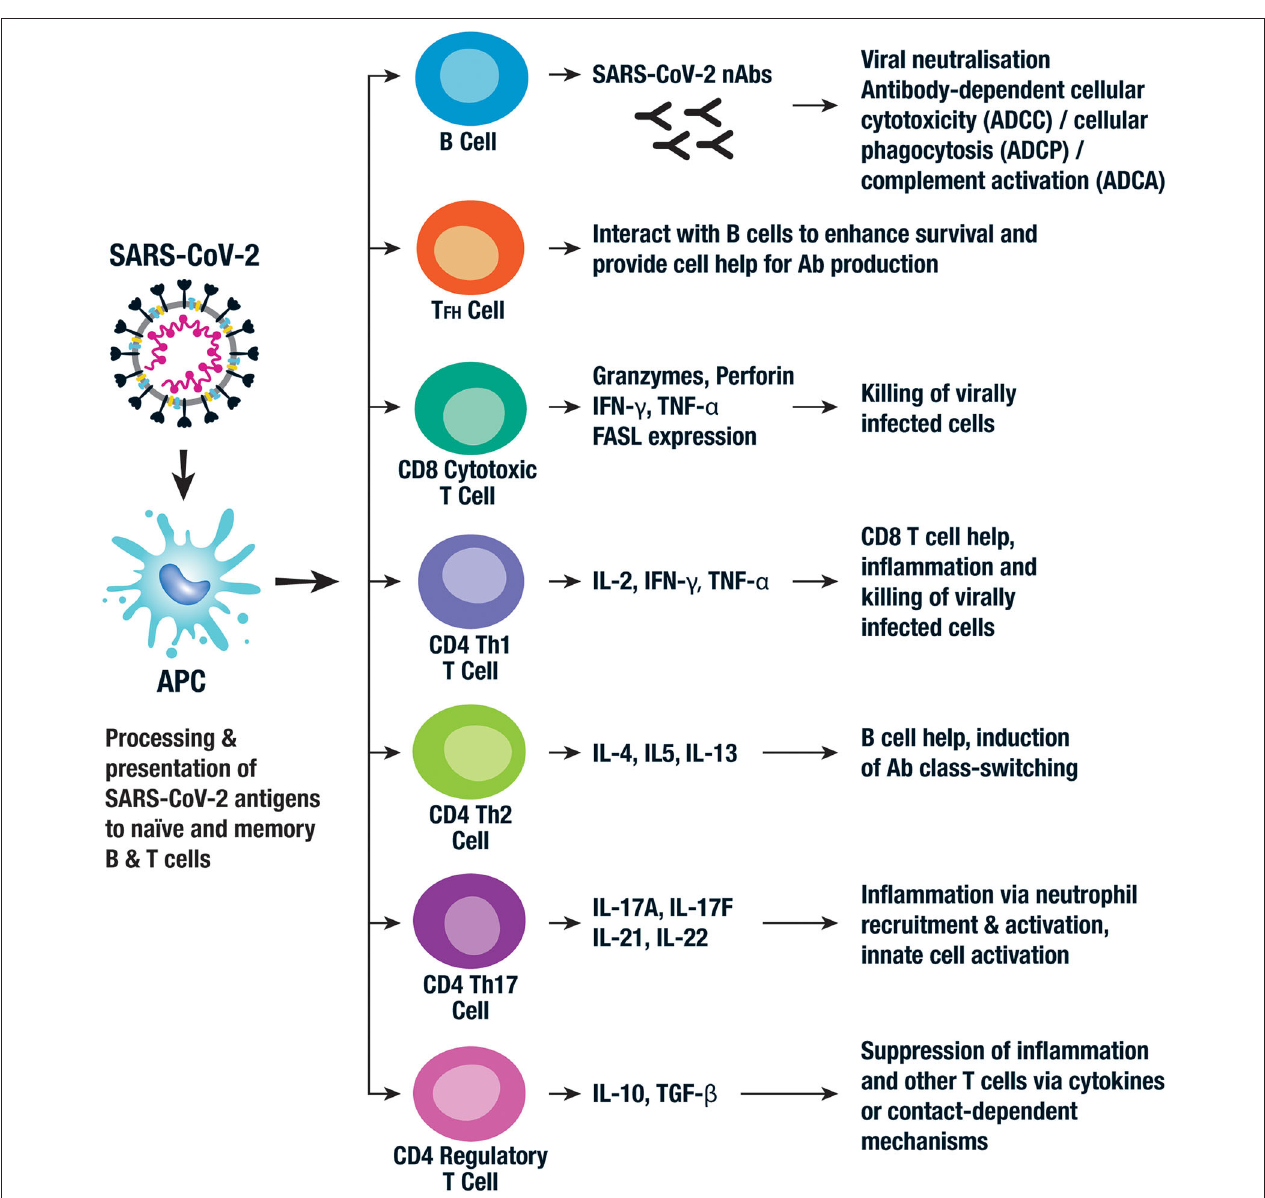
FIGURE 3 | Key components of the adaptive immune response to SARS-CoV-2. The adaptive immune response is activated following viral uptake and antigen processing by a range of APCs. The APCs present viral antigen to B cells which then differentiate into antibody producing plasma cells. The neutralizing antibodies (nAbs) then bind to key viral proteins, such as the spike protein, and neutralize their activity. Other Ab-mediated antiviral functions include antibody dependent cellular cytotoxicity (ADCC), antibody dependent cellular phagocytosis (ADCP), and antibody dependent complement activation (ADCA). Cytotoxic CD8 + T cells kill virally infected cells via the production of granzymes and perforin and the expression of Fas ligand (FasL), all of which mediate cellular apoptosis. A series of CD4 + T cell populations are involved in the adaptive cellular response to SARS-CoV-2. Follicular helper T cells (T FH ) and Th2 CD4 + T cells both provide help for B cell antibody production. Th1 and Th17 CD4 + T cells are also thought to play a role in the inflammatory response and viral killing. CD4 + regulatory T cells have been implicated with an immunoregulatory role in SARS-CoV-2 infection via the production of anti-inflammatory cytokines and contact-mediated cellular suppression. Whether CD8 + Tregs and Bregs play a role is not currently